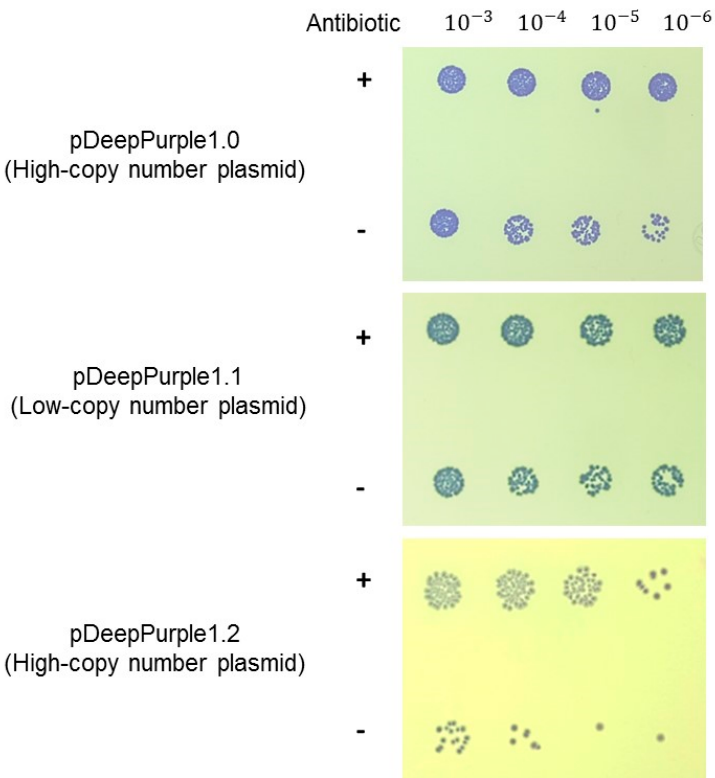
Figure 3. Stability test of the cloning plasmid set. Cells were analyzed as described in Materials and Methods after grown 24 h in the presence (+) or absence ( − ) of the selection marker (antibiotic). Serial dilutions are indicated on top of the spot analysis. Selection plates contained the selective agent for each